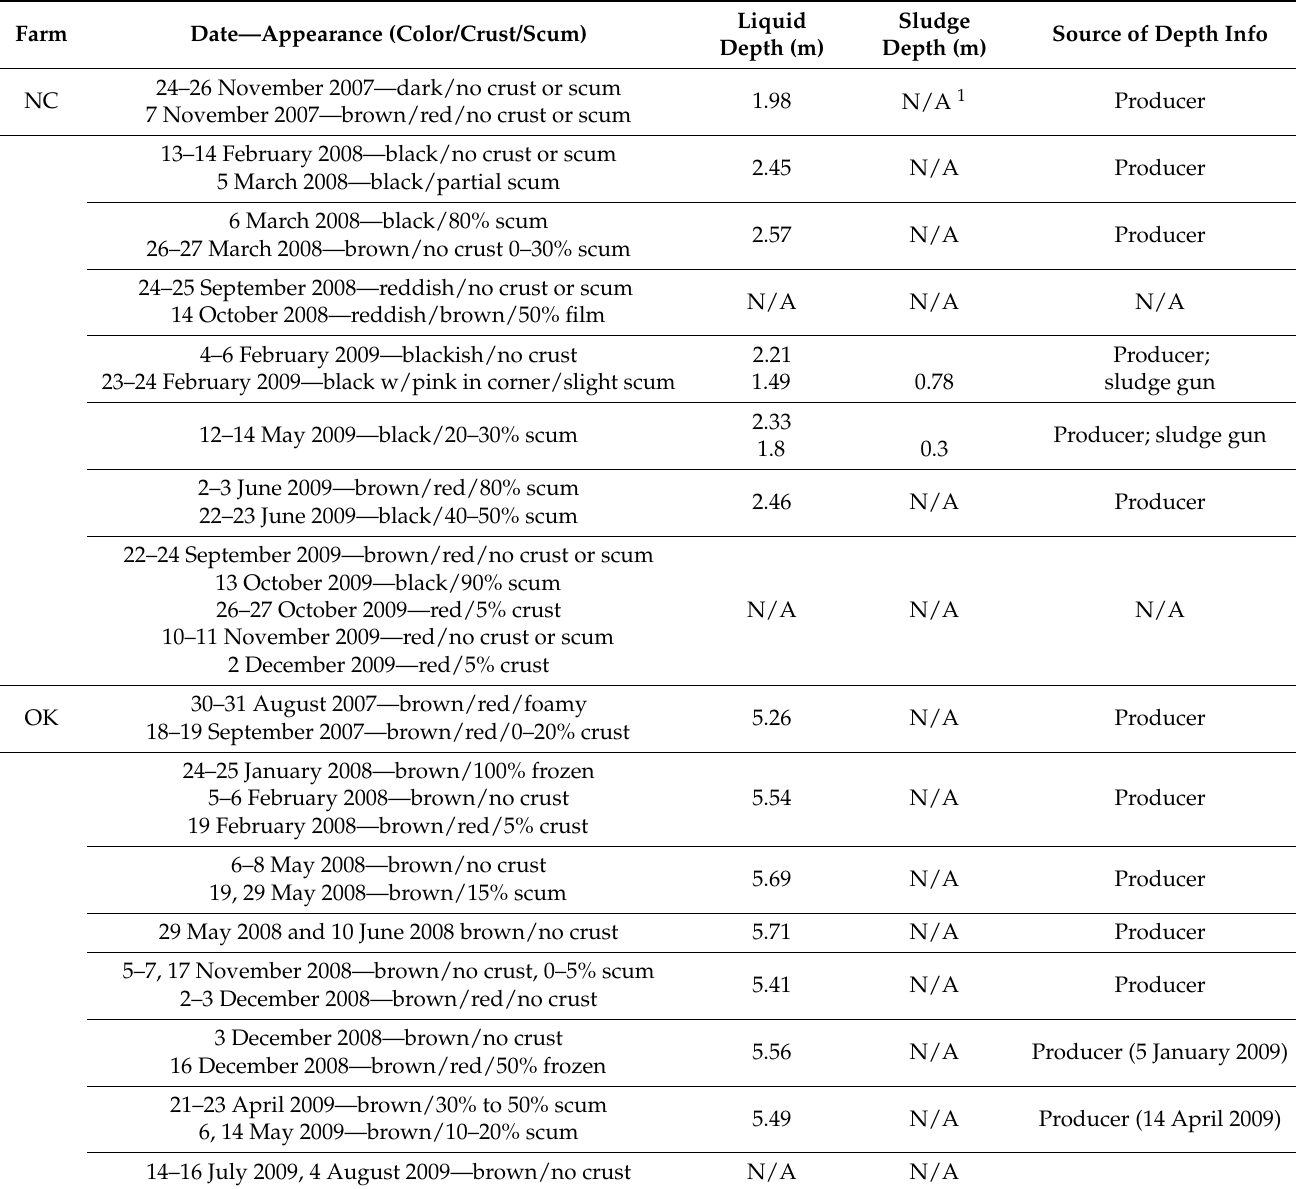
Table 2. Physical characteristics of